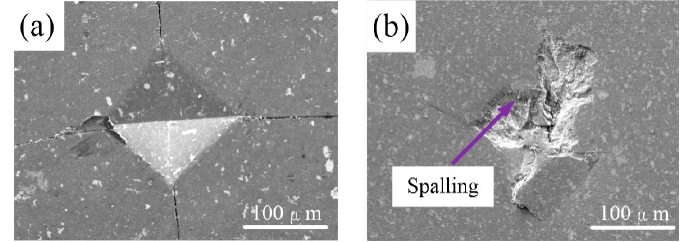
Figure 8. Indentation morphology of ( a ) composite H and ( b ) composite C.